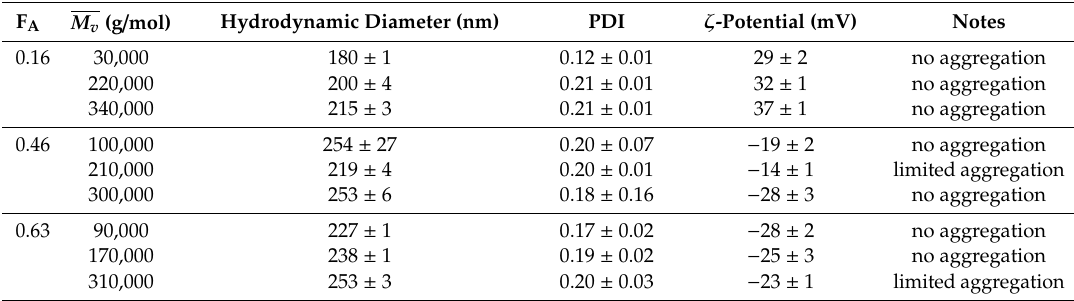
Table 2. Characterization of hydrochloride chitosan (CH) / sodium hyaluronate (HA) coacervates after dilution 1:10 ( v / v ) in deionized water. Coacervates were fabricated using chitosans at di ff erent fractions of acetylated units (F A ) and viscosity average molar masses ( M v ). The hydrodynamic diameter, aggregation at time zero, polydispersity index (PDI) and surface charge, i.e., ζ -potential, (all of them ± SD) of the resulting formulations are